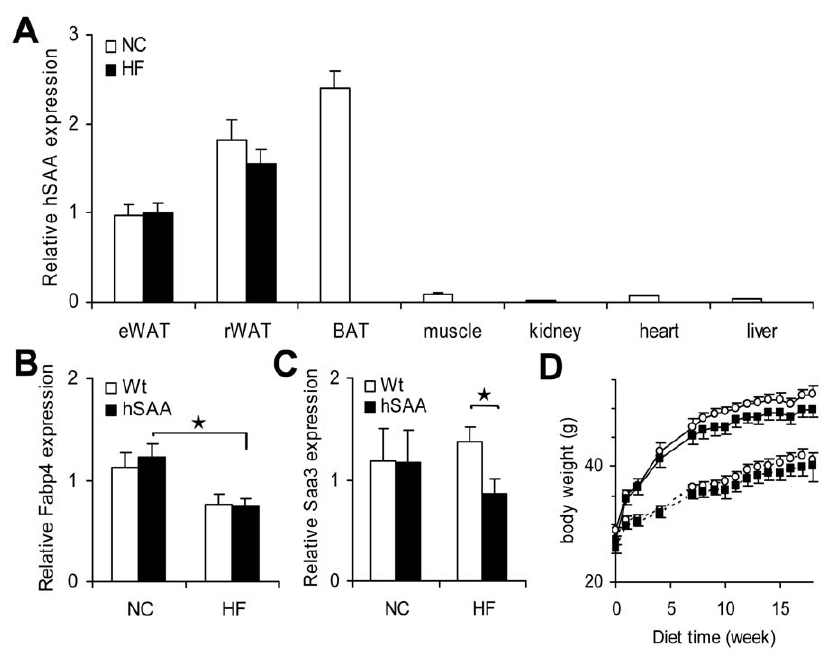
Figure 2. Analyses in hSAA transgenic male mice: gene expression, and animal growth. ( A ) hSAA gene expression in various tissues including epididymal white adipose tissue (eWAT), retroperitoneal white adipose tissue (rWAT) and brown adipose tissue (BAT) was measured in hSAA transgenic animals (n=7) fed NC diet. hSAA gene expression was also measured in eWAT and rWAT from hSAA mice (n=10) after 18 weeks of HF diet. Expression was normalized to Rplp0. ( B ) and ( C ) Gene expression of Fabp4 and Saa3 in eWAT (n=7–10 male animals in each group), respectively. Expression was normalized to Rplp0. ( D ) Growth curves of wild type and hSAA transgenic animals fed NC (dashed line) or HF (solid line) diet for 18 weeks. Open circles, wild type mice; filled squares hSAA mice (n=7–10 per group).*, p , 0.05. Values are given as mean 6 SEM.